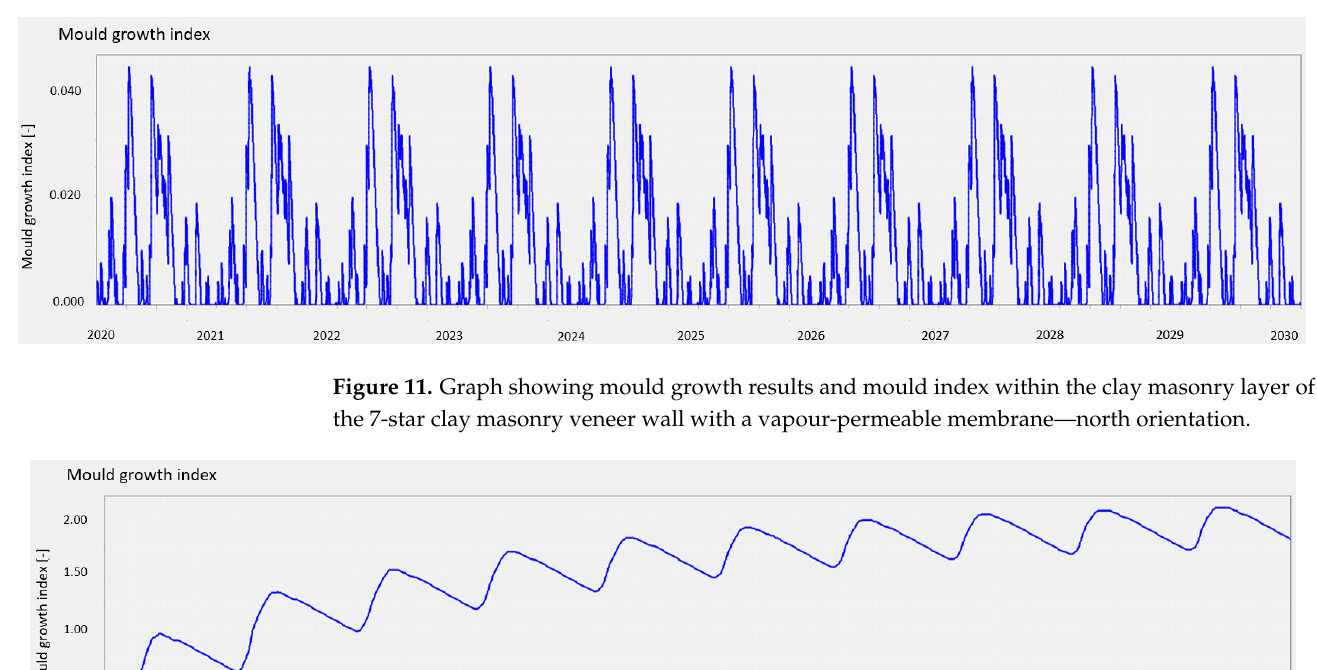
Figure 11. Graph showing mould growth results and mould index within the clay masonry layer of